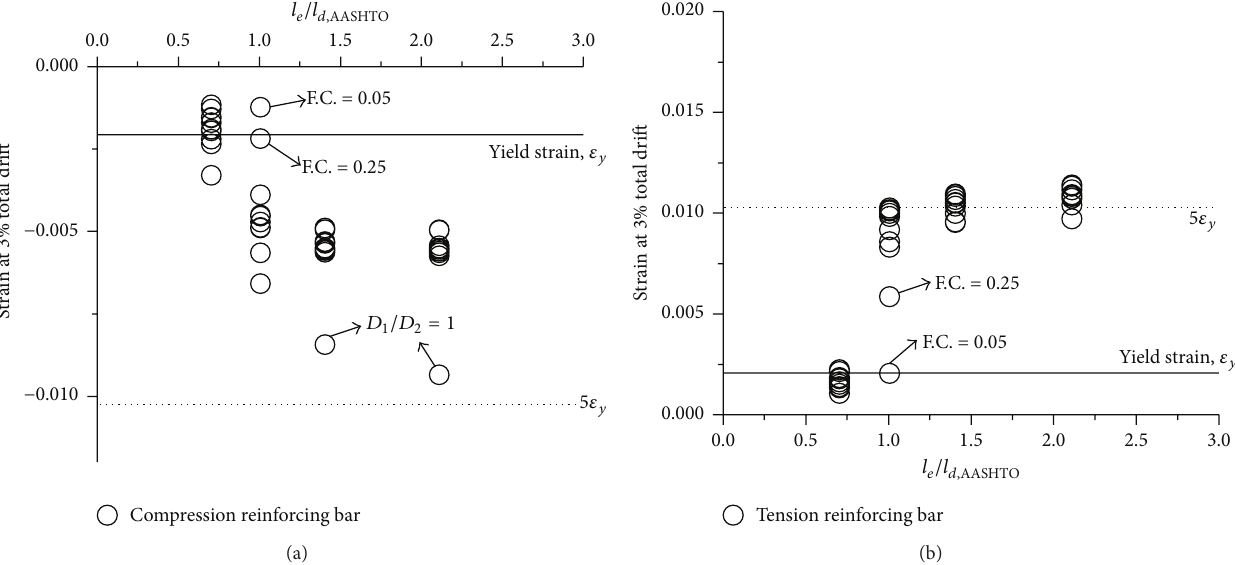
Figure 13: Variation in strain of reinforcement at 3.5% of drift with 𝑙 𝑒 /𝑙 𝑑, AASHTO : (a) compression reinforcing bar and (b) tension reinforcing bar.